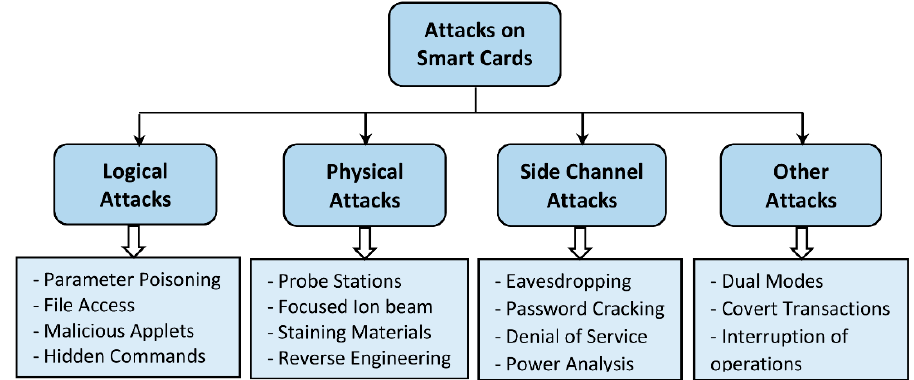
Figure 2. Taxonomy of attacks on smart cards.